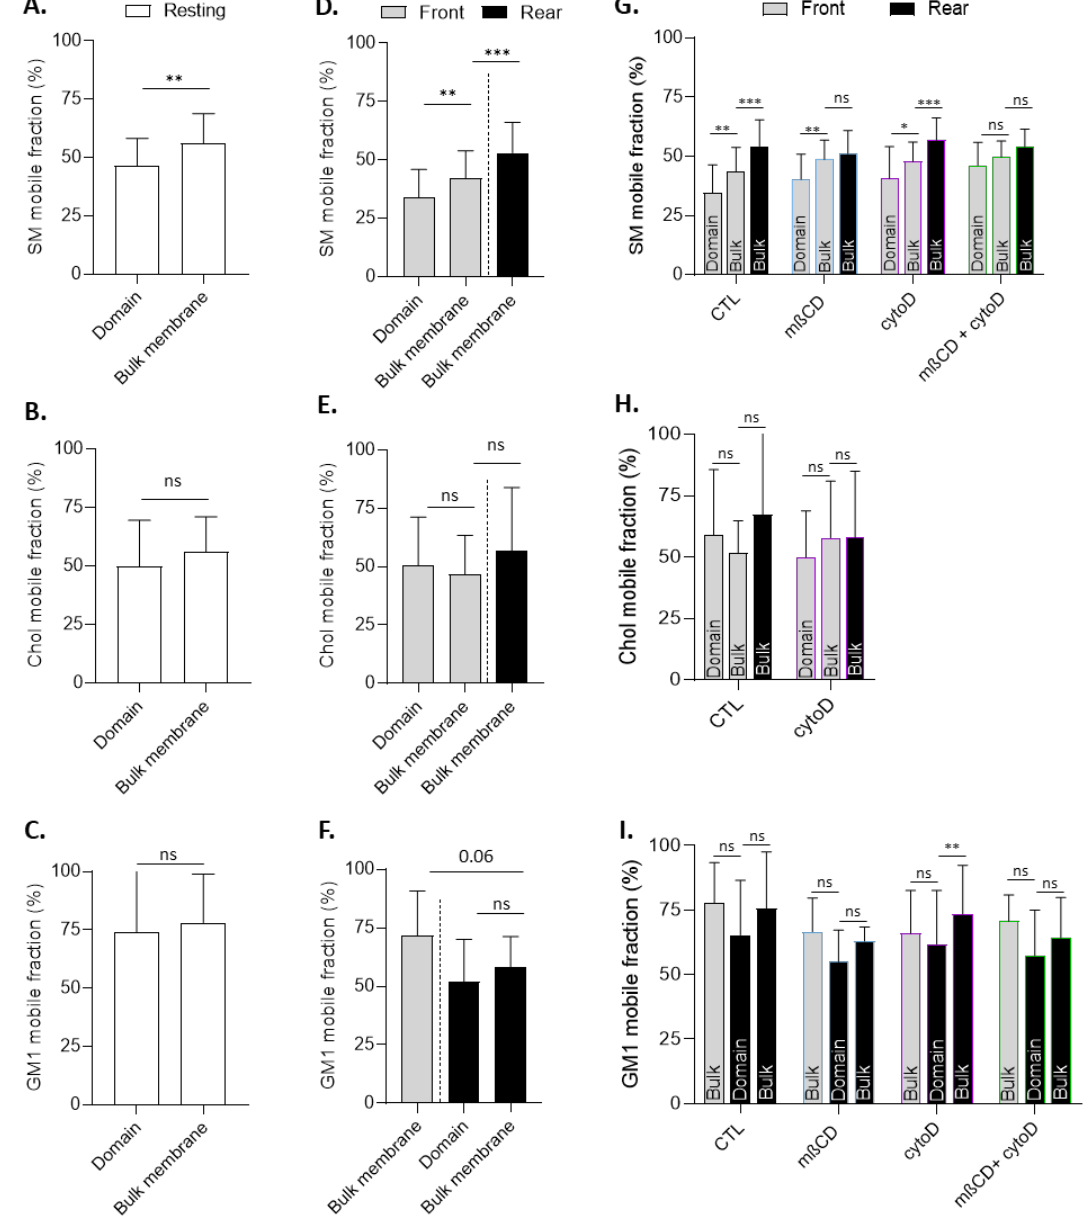
Figure 10. The lateral diffusion of sphingomyelin associated with domains is specifically restricted at the migration front in a cholesterol- and cytoskeleton-dependent manner. ( A – C ) Resting cells were single-labeled for SM (BODIPY-SM; A ), chol (theta; B ), or GM1 (CTxB; C ), then lateral diffusion was evaluated by FRAP on 2 regions of interest: lipid domain or bulk membrane. ( D – F ) Cells that migrated for 5 h in Ibidi chambers were single-labeled for SM ( D ), chol ( E ), or GM1 ( F ) as in ( A – C ), then lateral diffusion was evaluated by FRAP on 3 regions of interest, bulk membrane at the front, bulk membrane at the rear, and lipid domain either at the front (SM, chol) or at the rear (GM1). ( G – I ) Cells were left untreated or pretreated with 5 mM m β CD, 0.5 µM cytoD or a combination of both treatments (except for panel H since theta labeling was strongly reduced upon m β CD), then migrated for 5 h in Ibidi chambers. Cells were next single-labeled for SM ( G ), chol ( H ), or GM1 ( I ) and analyzed for lipid lateral diffusion as in ( D – F ). The data are expressed as the % of mobile fraction (means ± SD, n = 21–33 cells for each condition from 5 independent experiments). Paired t -test, one-way ANOVA, and two-way ANOVA, followed by Tukey’s multiple comparisons test. The statistics between different groups are indicated with bars on top of the